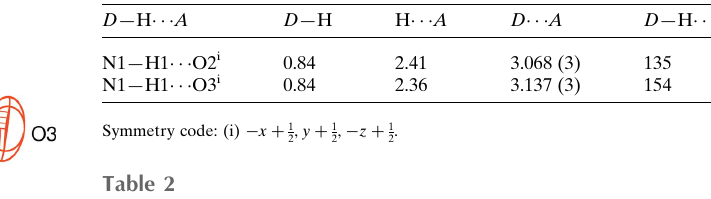
Table 2 Experimental